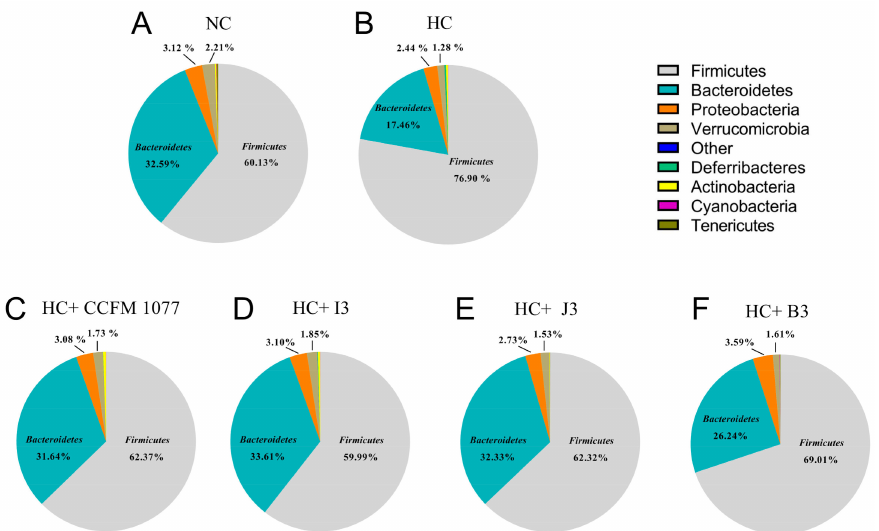
Figure 6. The relative abundance of the main phyla after consumption of high-cholesterol diet and administration of B. longum strains. ( A ) NC: non-cholesterol added diet; ( B ) HC: high-cholesterol diet; ( C ) HC+CCFM 1077: high-cholesterol diet + B. longum CCFM 1077; ( D ) HC+I3 high-cholesterol diet + B. longum I3; ( E ) HC+J3: high-cholesterol diet + B. longum J3; ( F ) HC+B3: high-cholesterol diet + B. longum